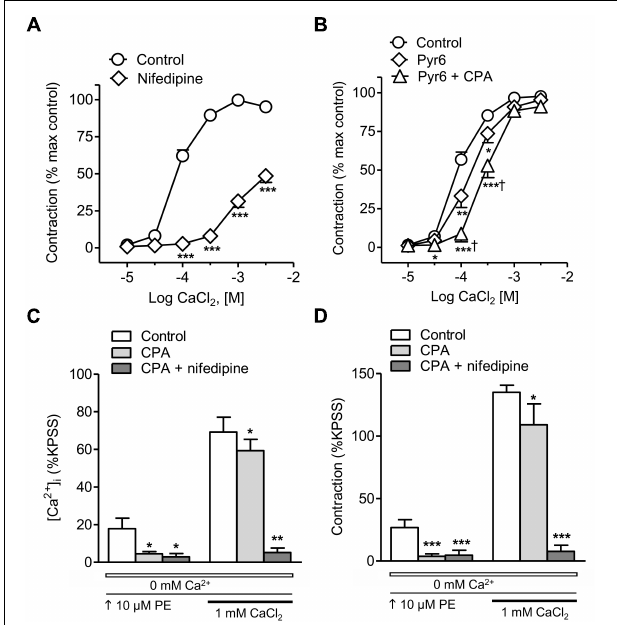
FIGURE 2 | α 1 -Adrenoceptor-elicited vasoconstriction in resistance arteries is mostly due to Ca 2 + entry through voltage-dependent L-type channels. (A,B) Average inhibitory effects of the selective L-type Ca 2 + channel blocker nifedipine (0.3 µ M) (A) or the inhibitor of the Orai1–mediated Ca 2 + entry Pyr6 (3 µ M) alone or in combination with the SERCA inhibitor CPA (10 µ M) (B ) on the CaCl 2 concentration-response curves (CRCs) in endothelium-denuded mesenteric resistance arteries kept in nominally Ca 2 + -free medium and stimulated with 10 µ M PE. (C,D ) Summarized data showing the effects of SR Ca 2 + store depletion by SERCA inhibition with CPA (10 µ M) alone or CPA plus nifedipine (0.3 µ M) on the changes in [Ca 2 + ] i (C) and contraction (D) in response to 10 µ M PE in resistance arteries kept in a nominally Ca 2 + -free medium (0 mM Ca 2 + , open bar) after Ca 2 + readmission (1 mM CaCl 2 , closed bar). Results are expressed as a percentage of control maximal responses (A,B) or the KPSS responses (C,D) . Values are means ± SEM of n = 6 arteries (one from each animal). ∗ P < 0.05, ∗∗ P < 0.01, ∗∗∗ P < 0.001 vs. control. † P < 0.05 vs.